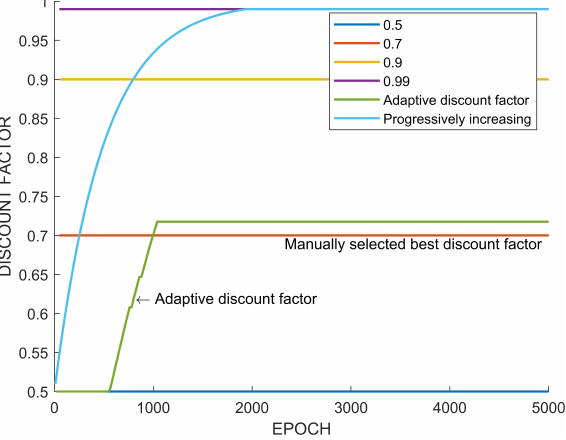
Figure 9. Adjustment of discount factor in Tetris. Table 2. Score comparison between fixed and adaptive discount factor in